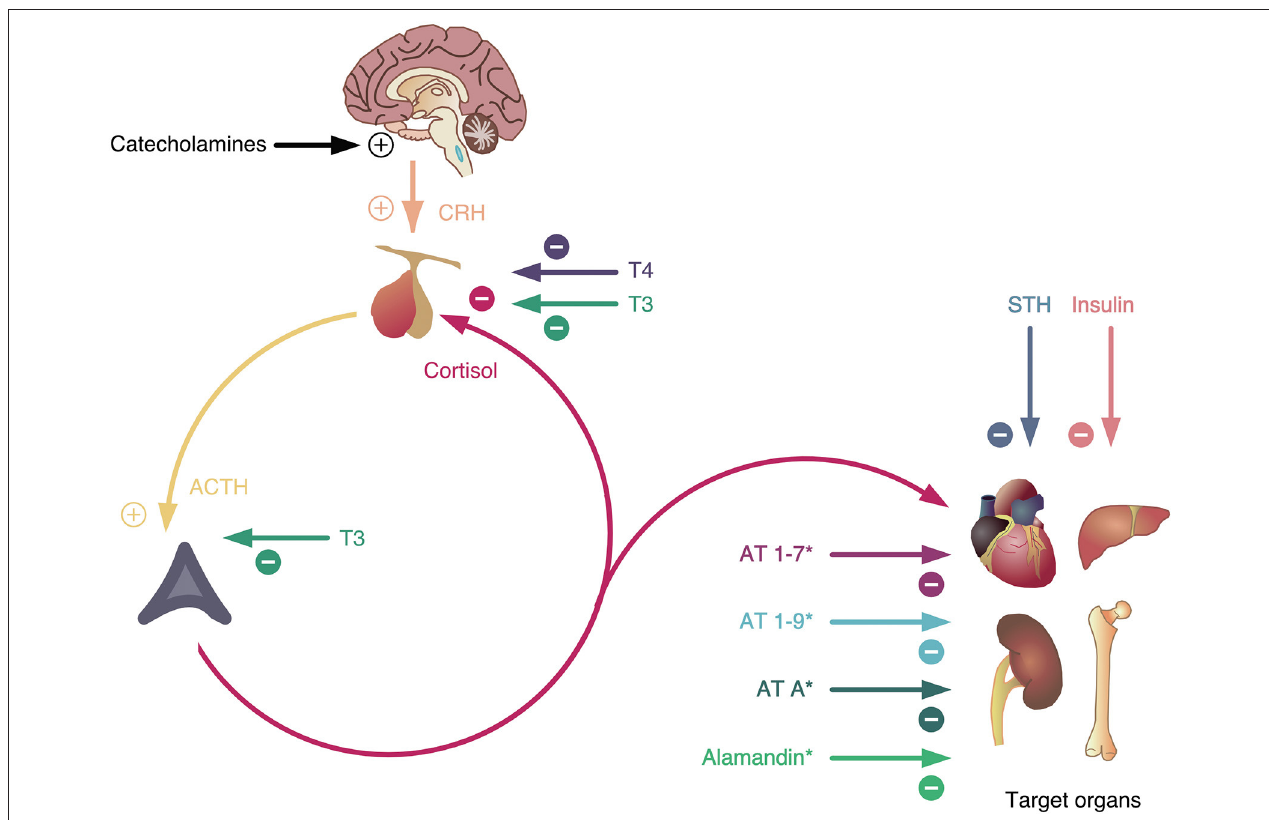
FIGURE 4 | The hypothalamus-pituitary-adrenal (HPA) axis is the major stress mediator system on an intermediate time scale. It is stimulated by catecholamines (representing the fast stress system) and inhibited by thyroid hormones (as slow mediators of stress and allostatic load). In addition, it has multiple antagonists inhibiting partial functions at peripheral levels of the processing structure, some of them (marked by *) resulting from ACE2 activation. AT, angiotensin; STH, somatotropic hormone. For more details see